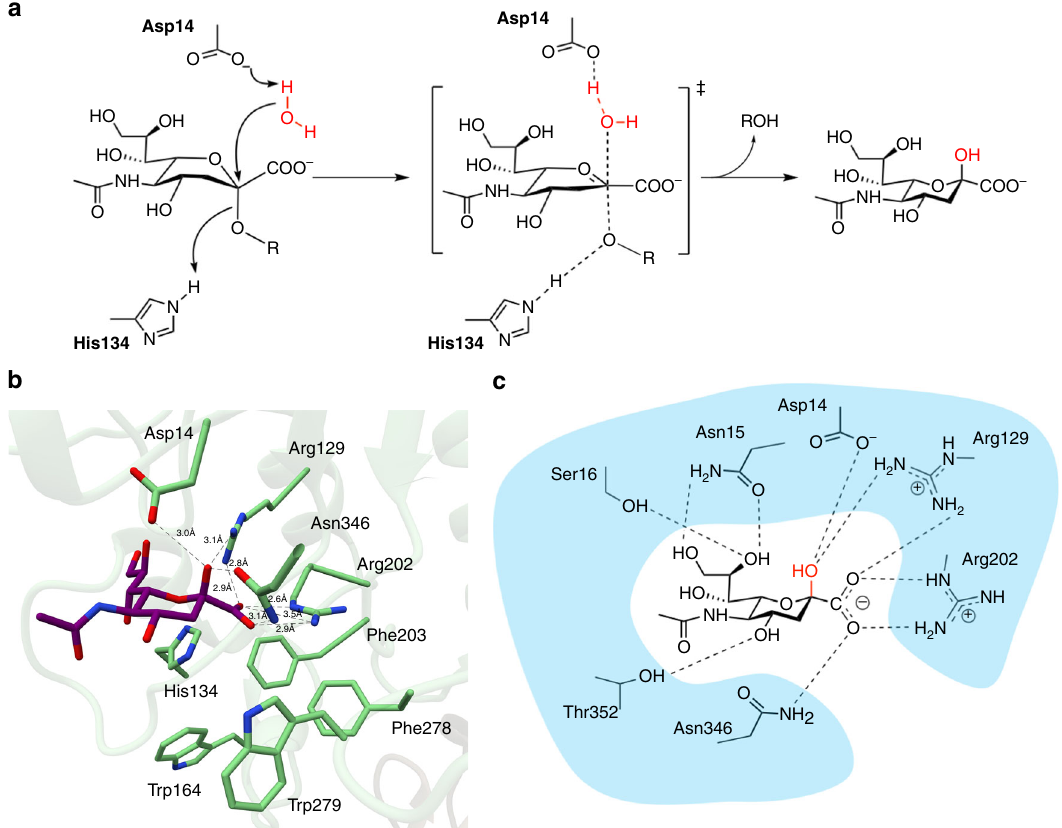
Fig. 5 EnvSia156 proposed catalytic mechanism. a Proposed inverting mechanism for EnvSia156 with Asp14 acting as the general catalytic base and His134 as the acid catalyst. b Structure of the EnvSia156 – Neu5Ac complex highlighting the two putative catalytic residues (Asp14 and His134), the carboxylate- coordinating triad (Arg129, Arg202, Asn346) and the hydrophobic pocket that possibly constitutes the + 1 binding site (Trp164, Phe203, Trp279, Phe278). c Schematic representation of the Neu5Ac bound to EnvSia156 − 1 binding sub-site, showing all the hydrogen bond interactions between both